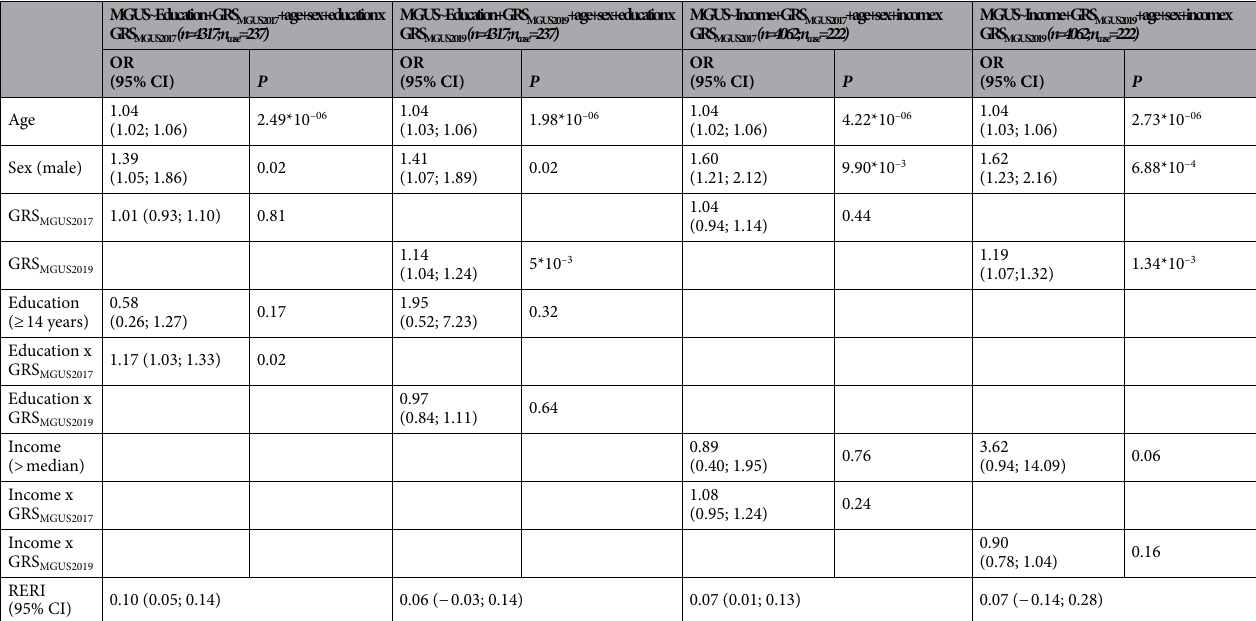
Table 3. Sex-and age-adjusted odds ratios (OR) and 95% confidence intervals (95% CI) for the effects on MGUS status in logistic regression models including main effects and interaction terms of the genetic effect (GRS MGUS ) and dichotomised education or income as indicators of socioeconomic position (SEP) with the lower SEP category as reference group (relative excess risk due to interaction,